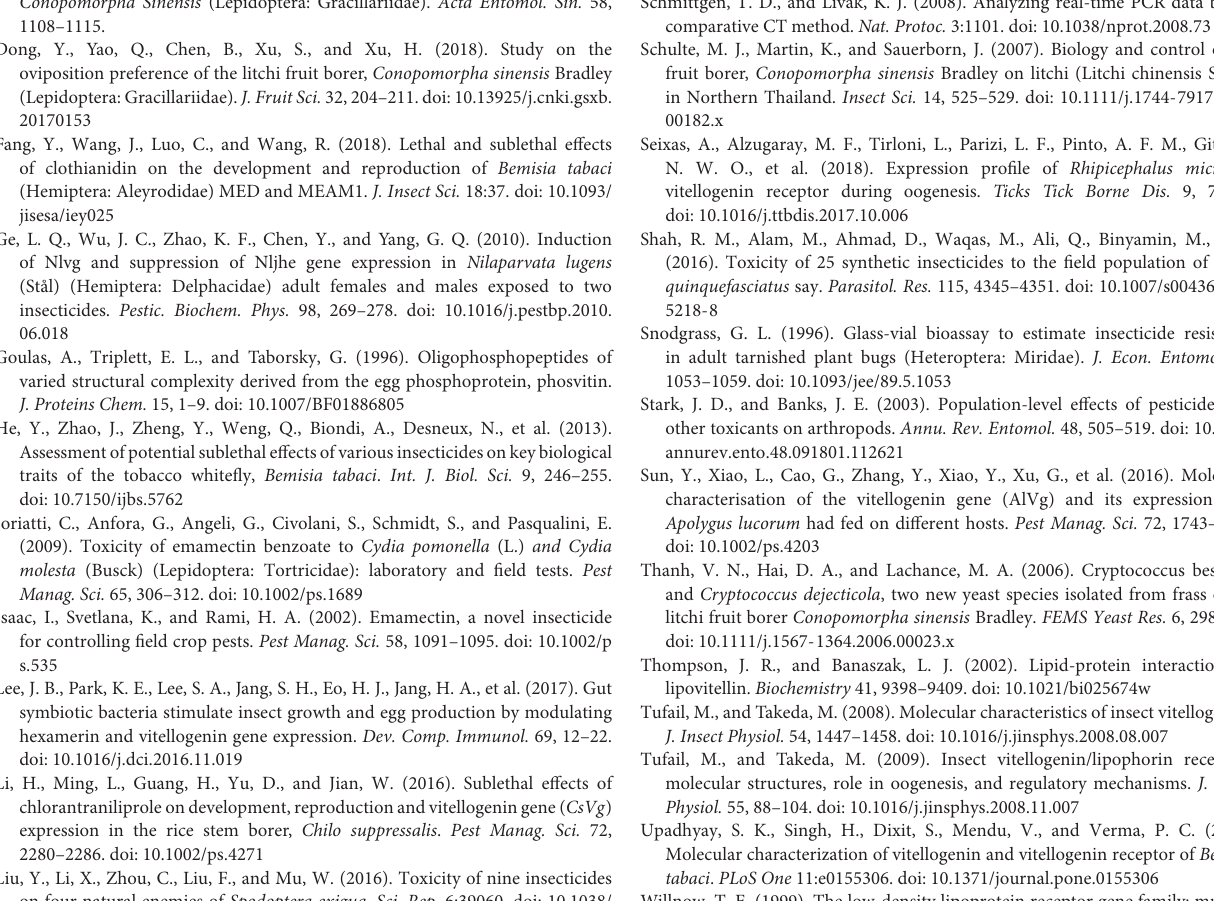
tabaci . PLoS One 11:e0155306. doi: 10.1371/journal.pone.0155306 Willnow, T. E. (1999). The low-density lipoprotein receptor gene family: